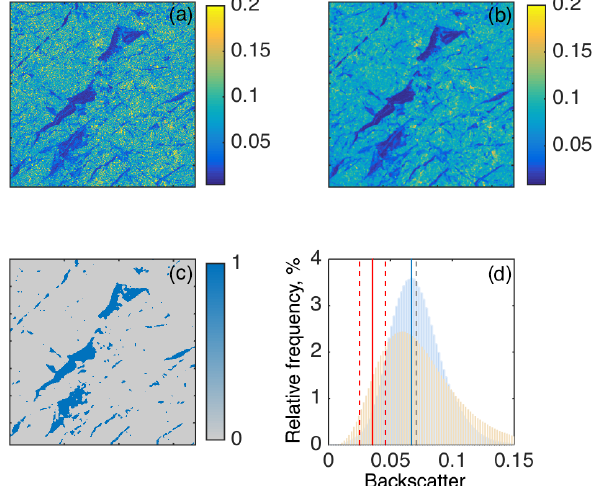
Figure 3. Threshold technique used to calculate lead fraction from SAR images: (a) a subset of 680 × 680 pixels showing backscat- ter values; (b) same as (a) but after median filter has been applied; (c) the resulting lead detection (1 – lead, 0 – ice); (d) histogram of an example SAR scene taken on the 1 March 2009 (blue) with lines showing the peak (blue), threshold defined as peak minus 1.5 standard deviation (red), other thresholds (when 1 standard devia- tion and 2 standard deviations are used, dashed red); and the mean is shown by the grey dashed line. The beige bars represent the un- filtered